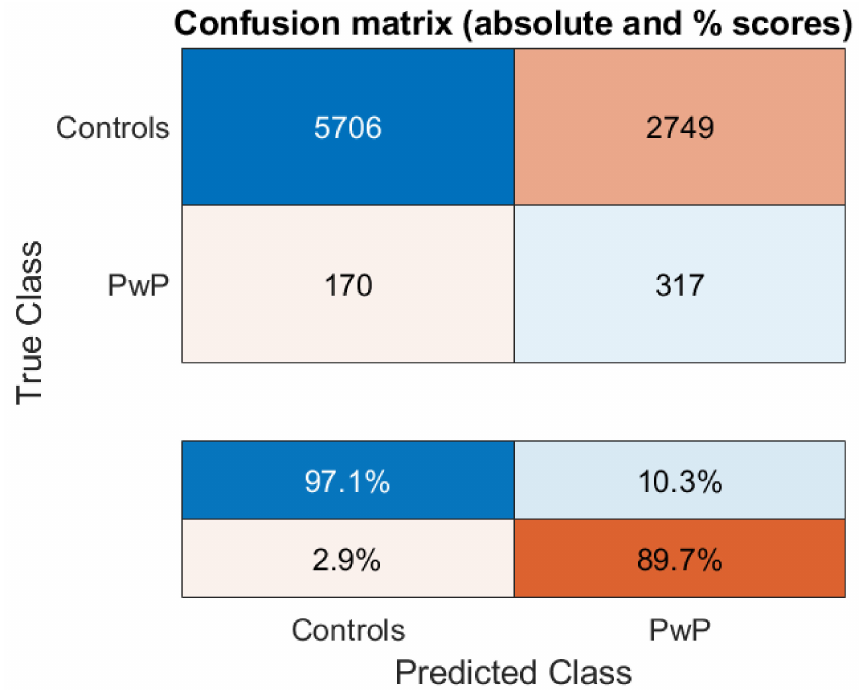
Figure 3. Confusion matrix denoting performance on the held-out unbalanced dataset ( n = 8942 sam- ples) when using the best performing model selected from the results presented in Figure 2 (SVM with 27 features selected using